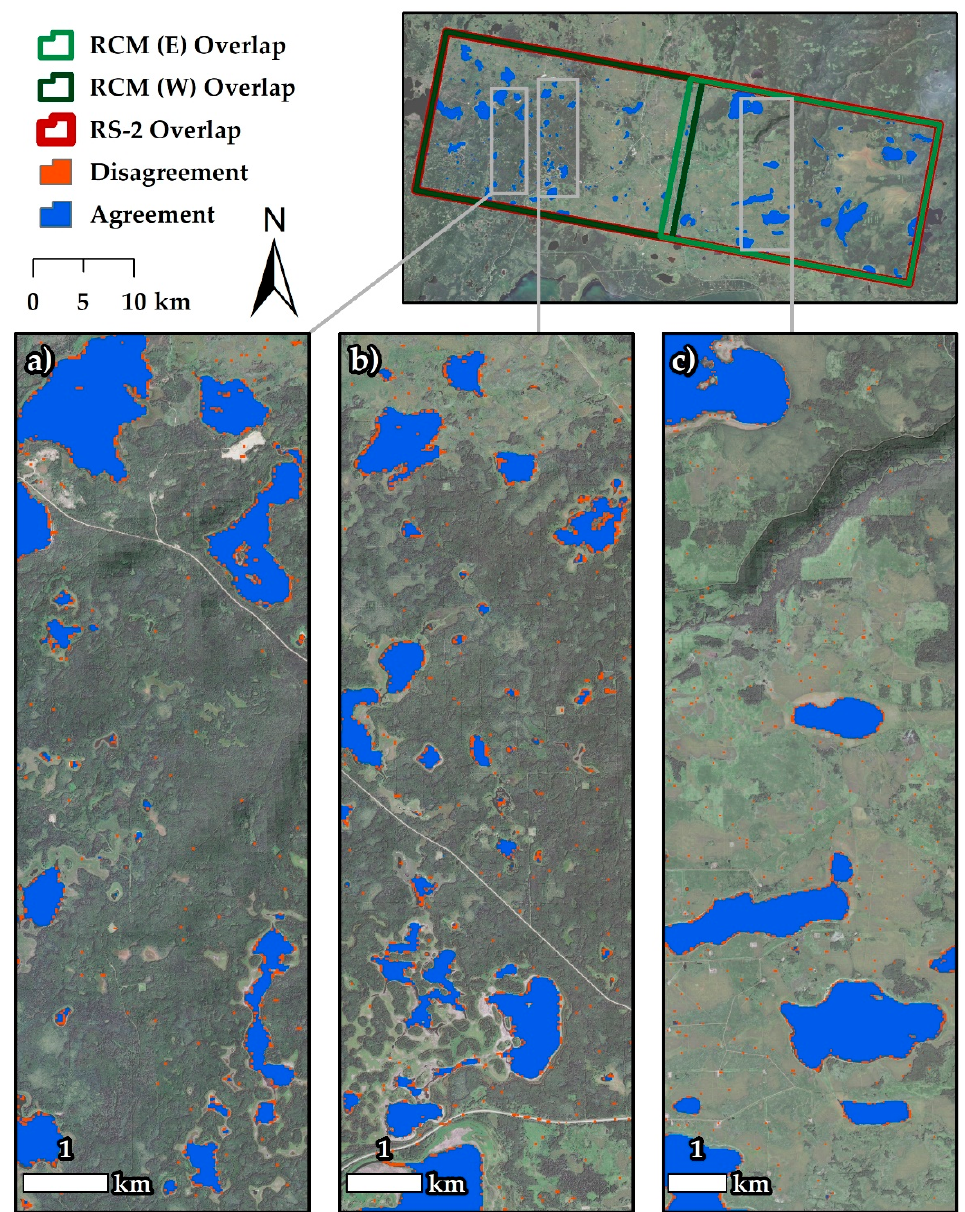
Figure 7. Comparison of water masks for ( a ) overlapping north and south Radarsat-2 (RS-2) scenes, ( b ) north–south (west) simulated Radarsat Constellation Mission (RCM) scenes, and ( c ) north–south (east) RCM scenes.